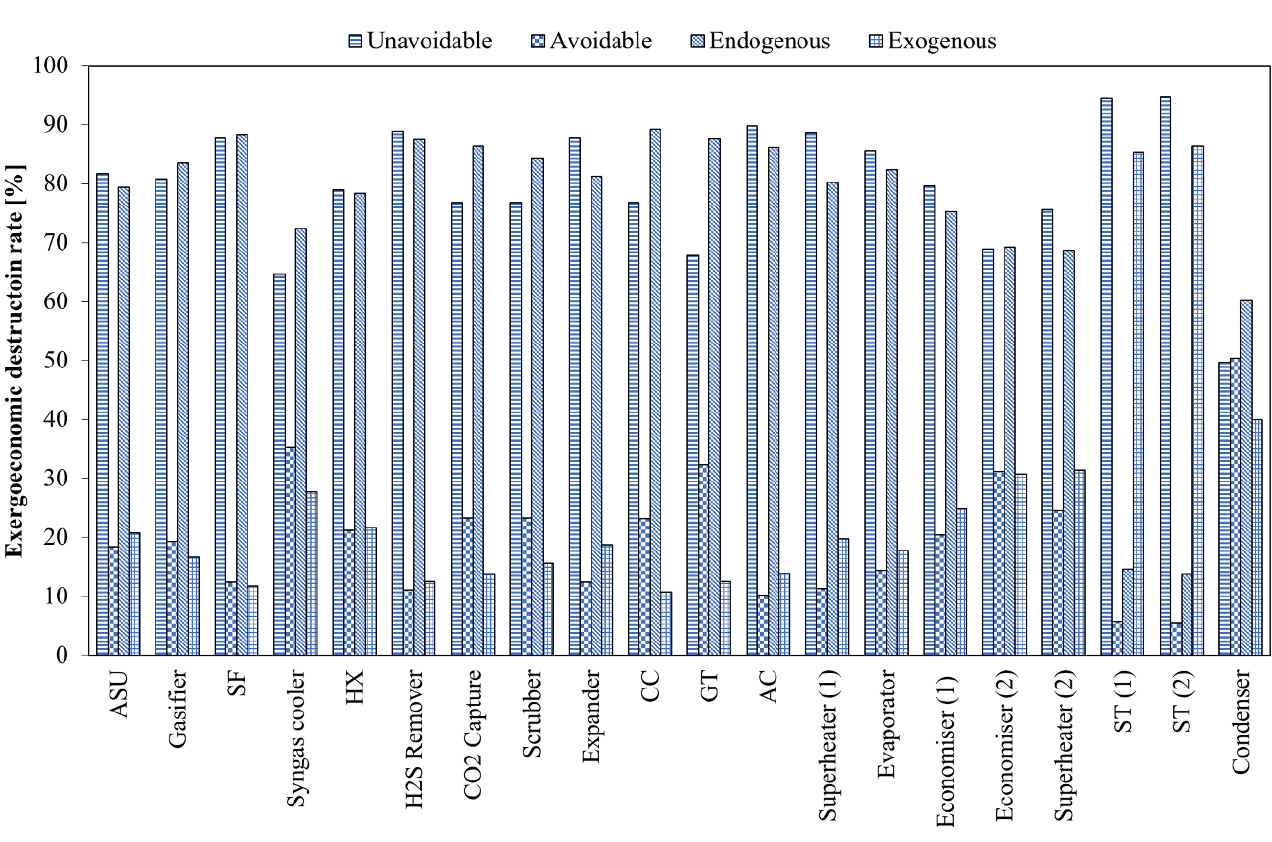
Figure 6. Advanced exergoeconomic analysis results obtained for the proposed integrated solar-gasification cycle (ISGC) system. ASU: Air separation unit; CC: Combustion chamber; GT: Gas turbine; HX: heat exchanger; SF: Solar field; ST: Steam turbine.